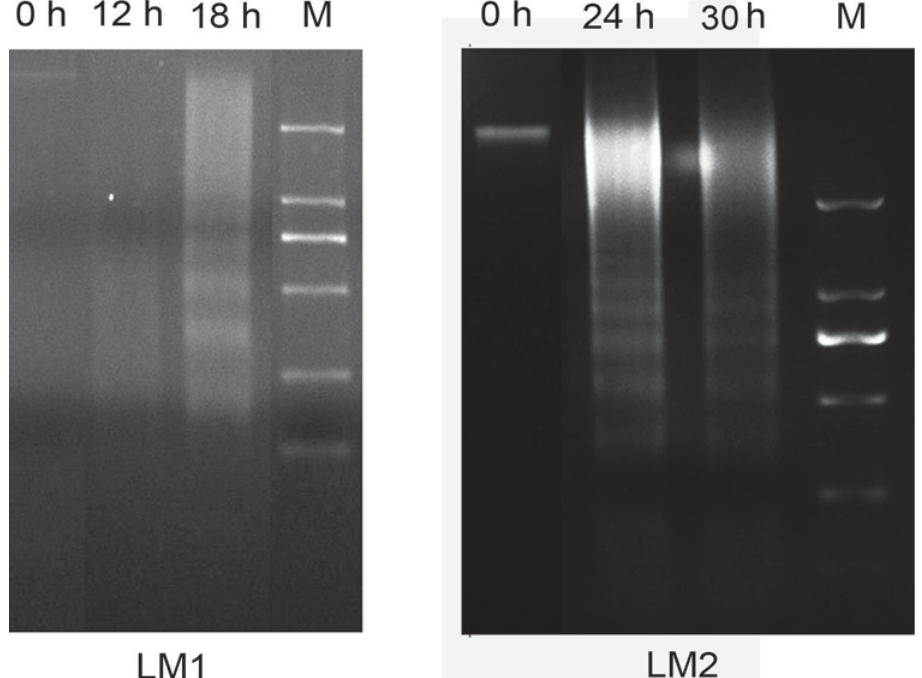
Figure 4- Effect of LM1 and LM2 on DNA fragment in CAL-27. CAL-27 cells were treated with LM1 and LM2 for different time periods and then collected. DNA was separated, followed by DNA gel electrophoresis (M, Marker: 2,000 bp, 1,000 bp, 750 bp, 250 bp, 100